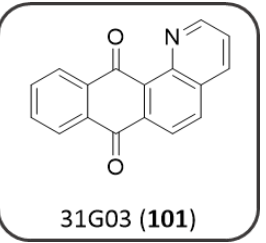
Figure 20. Chemical structure of AQ 31G03.